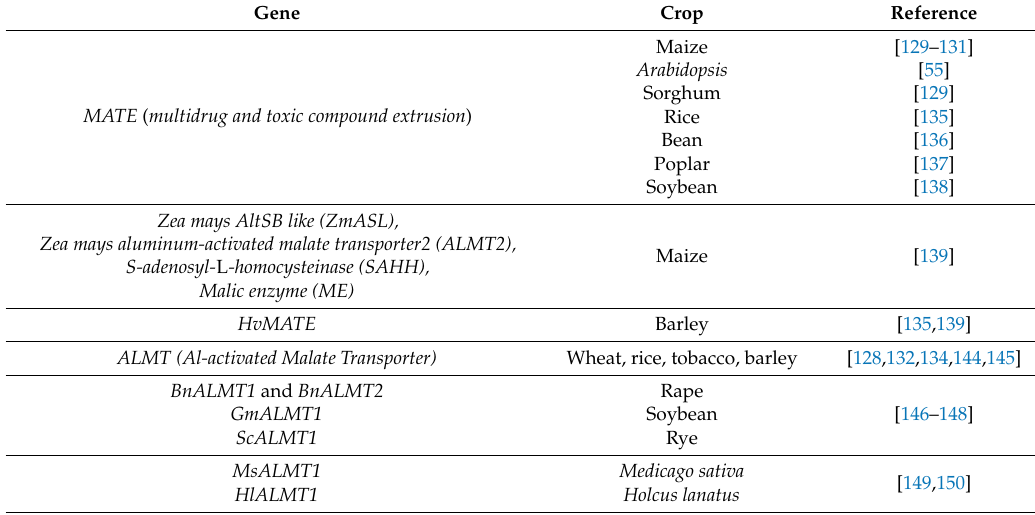
Table 3. Genes associated with Al tolerance in different